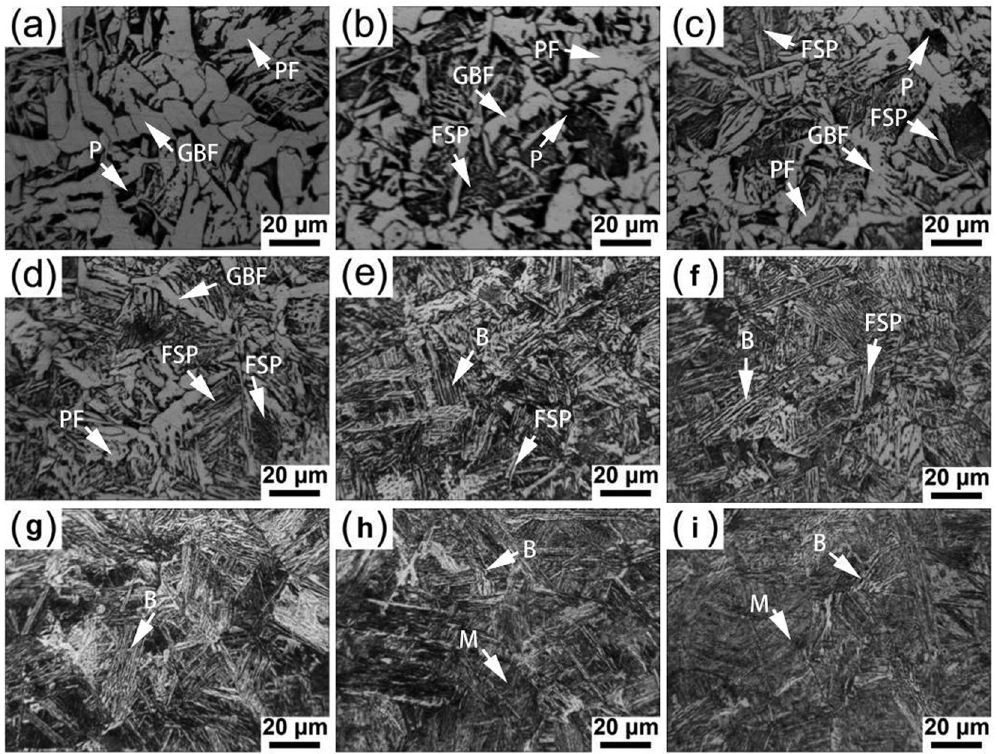
Figure 2: The microstructures of steel no. 1 under different cooling rates. ( a ) 1°C/s, ( b ) 2°C/s, ( c ) 3°C/s, ( d ) 5°C/s, ( e ) 8°C/s, ( f ) 10°C/s, ( g ) 15°C/s, ( h ) 25°C/s, and ( i ) in Figure 5 ( c and f ) . Thick red lines are those grain lines. The grain boundary angles of ferrite laths in FSP boundary angles greater than 15°, while those grain are very small ( mainly < 4° ) , and these grain boundaries boundary angles less than 4° are marked with thin black are mostly subgrain boundaries. While for AF, the grain